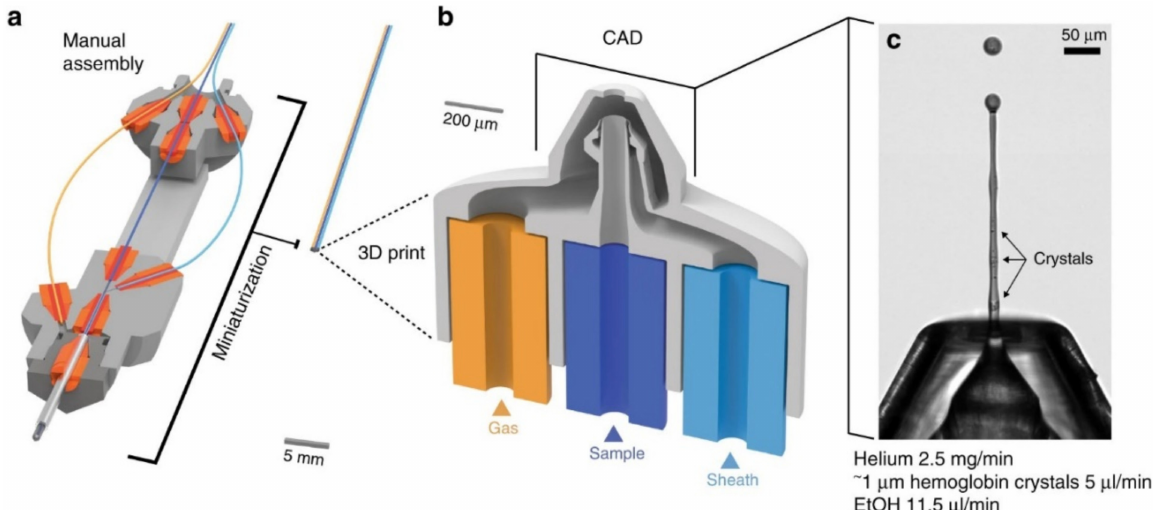
Figure 8. Three-dimensional printed double-flow-focusing GDVN. ( a ) The design assembly consisting of inserting three glass capillaries into a machined 10 cm long aluminium body, ( b ) 3D schematics of the gas orifice with three capillary inlets for gas, liquid sample, and sheath flow, ( c ) the 3D printed nozzle in operation jetting a solution containing 3 µ m Hemoglobin crystals (reproduced with permission from